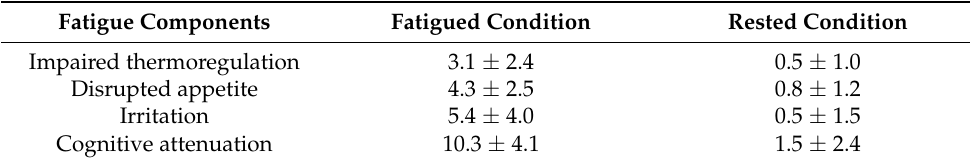
Table 2. Measures of sleep deprivation in rested and fatigued conditions on the CHICa subscales. All p <